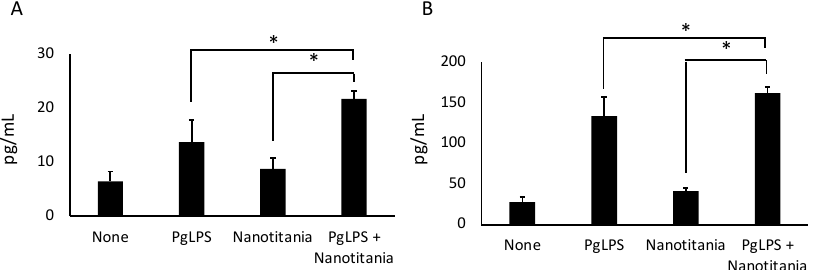
Figure 5. Protein levels of IL-6 ( A ) and IL-8 ( B ) were measured by ELISA after incubation with 10 µg/mL PgLPS, 10 µg/mL nanotitania and both stimulants together. Each data point indicates the average of six gene expression quantification results (n = 6). Bars indicate standard deviation, and asterisks indicate p < 0.05.